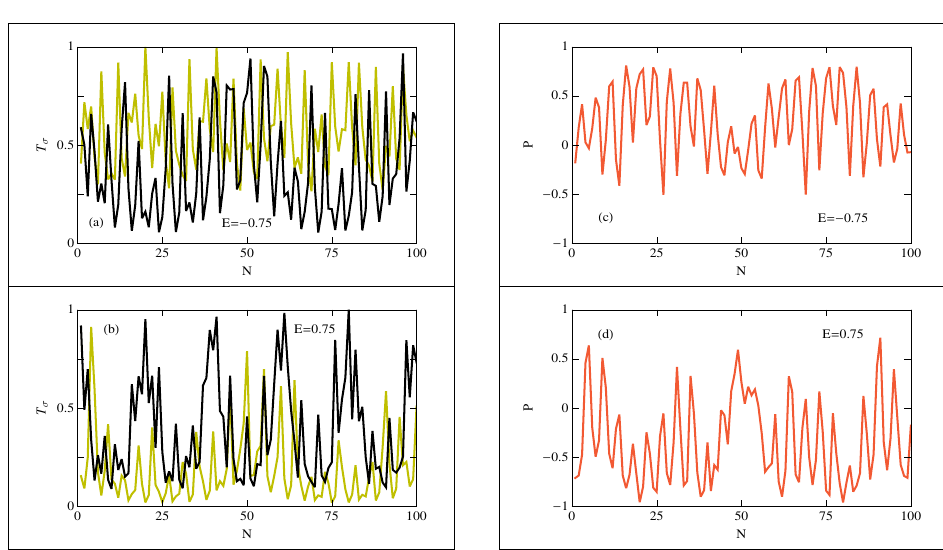
Figure 8. Spin dependent transmission probabilities ( T ↑ → light green color and T ↑ → black color) and corresponding spin polarization co-efficient P as a function of system size N at two typical energies. Here we set A x = 0.25, φ ν = 0 and θ i = 0 ∀ i